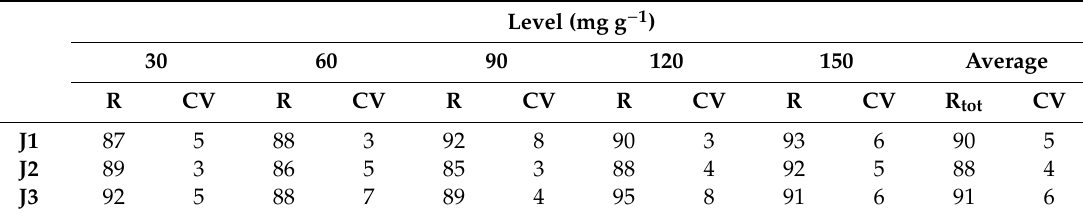
Table 3. Validation results for recovery results a